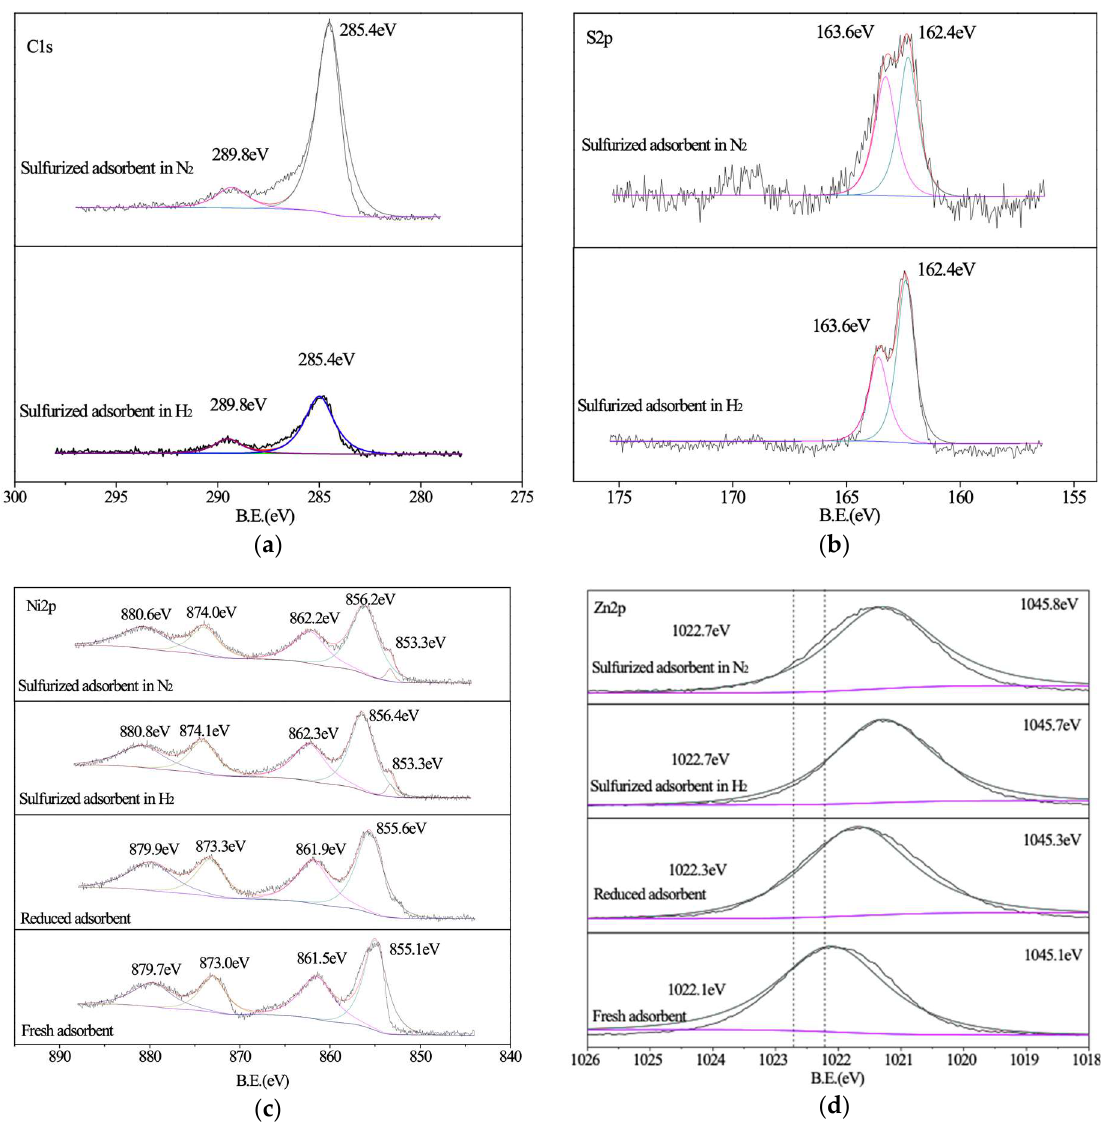
Figure 6. XPS spectra of Ni and Zn elements ( a ) C; ( b ) S; ( c ) Ni; ( d ) Zn.